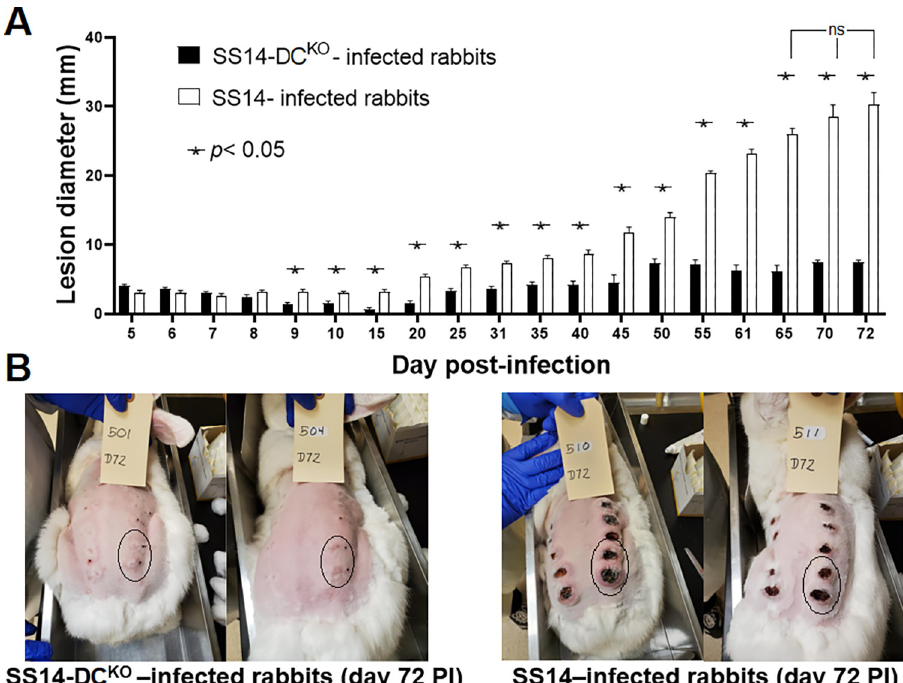
Fig 4. Lesion progression in infected animals. (A) Measurements of lesion diameter (mm) over time in rabbits infected with the SS14 strain and the SS14-DC KO strain. Statistical analyses were performed using one-way ANOVA with the Dunnett correction of multiple comparisons or Student’s t -test, with significance set at p < 0.05, indicated by an asterisk. The designation “ns” indicates lack of significance in lesion diameter of rabbits infected with the WT strain between day 65 and subsequent time points. (B) Pictures of the animals still in the study at day 72 post-infection showing large, ulcerated lesions in control rabbits (right panel), and significantly smaller ( p < 0.05) lesions in animals infected with the knockout strain (left panel). Circled areas represent lesions that were not yet biopsied at the time the picture was taken. Black ink dots near the lesion area mark the injection sites.